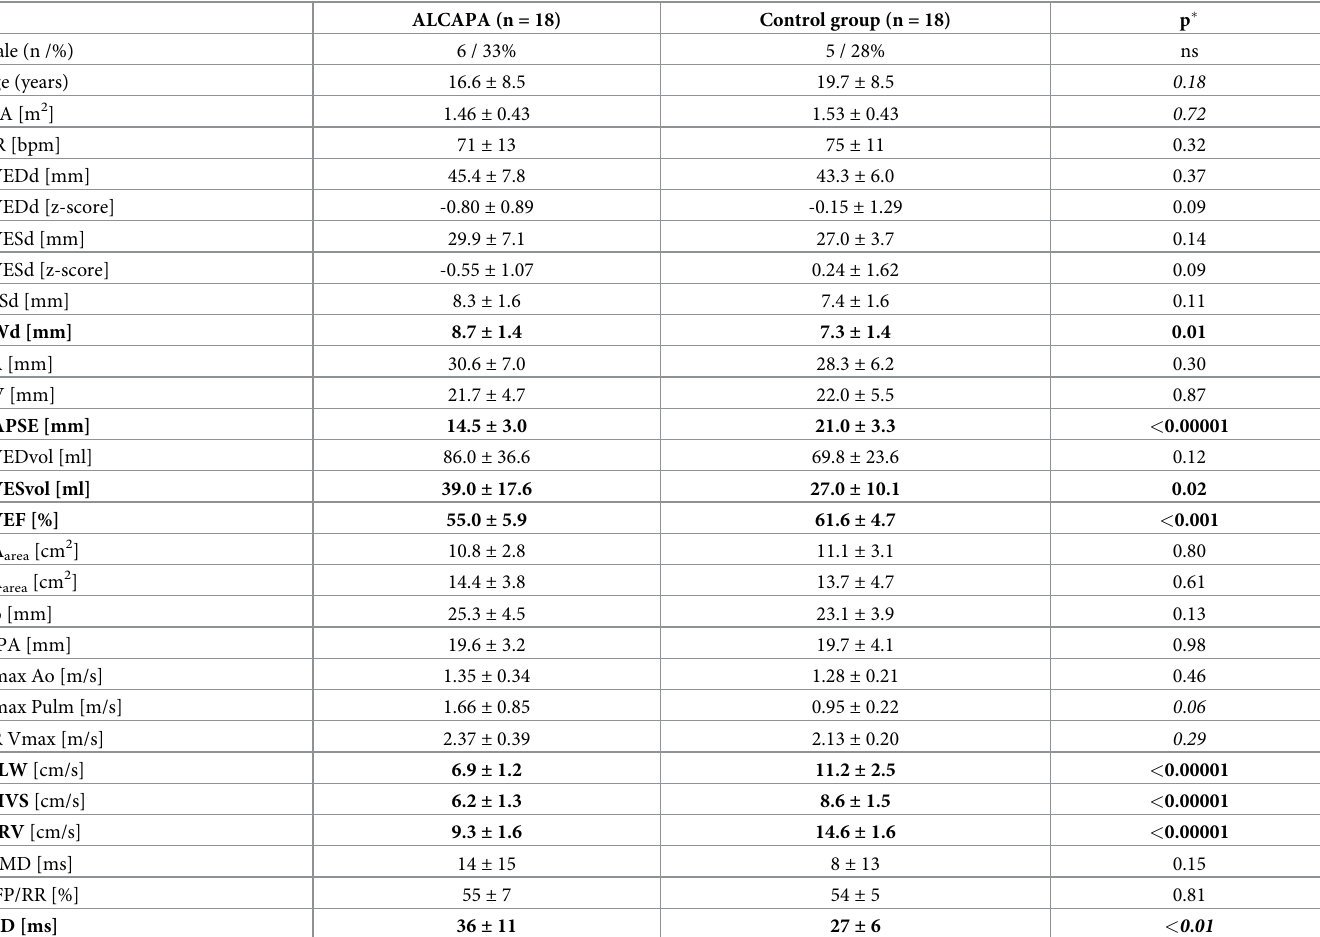
Table 2. Comparison of the demographic and echocardiographic parameters between the study population at last follow-up and the control group. ALCAPA (n = 18)